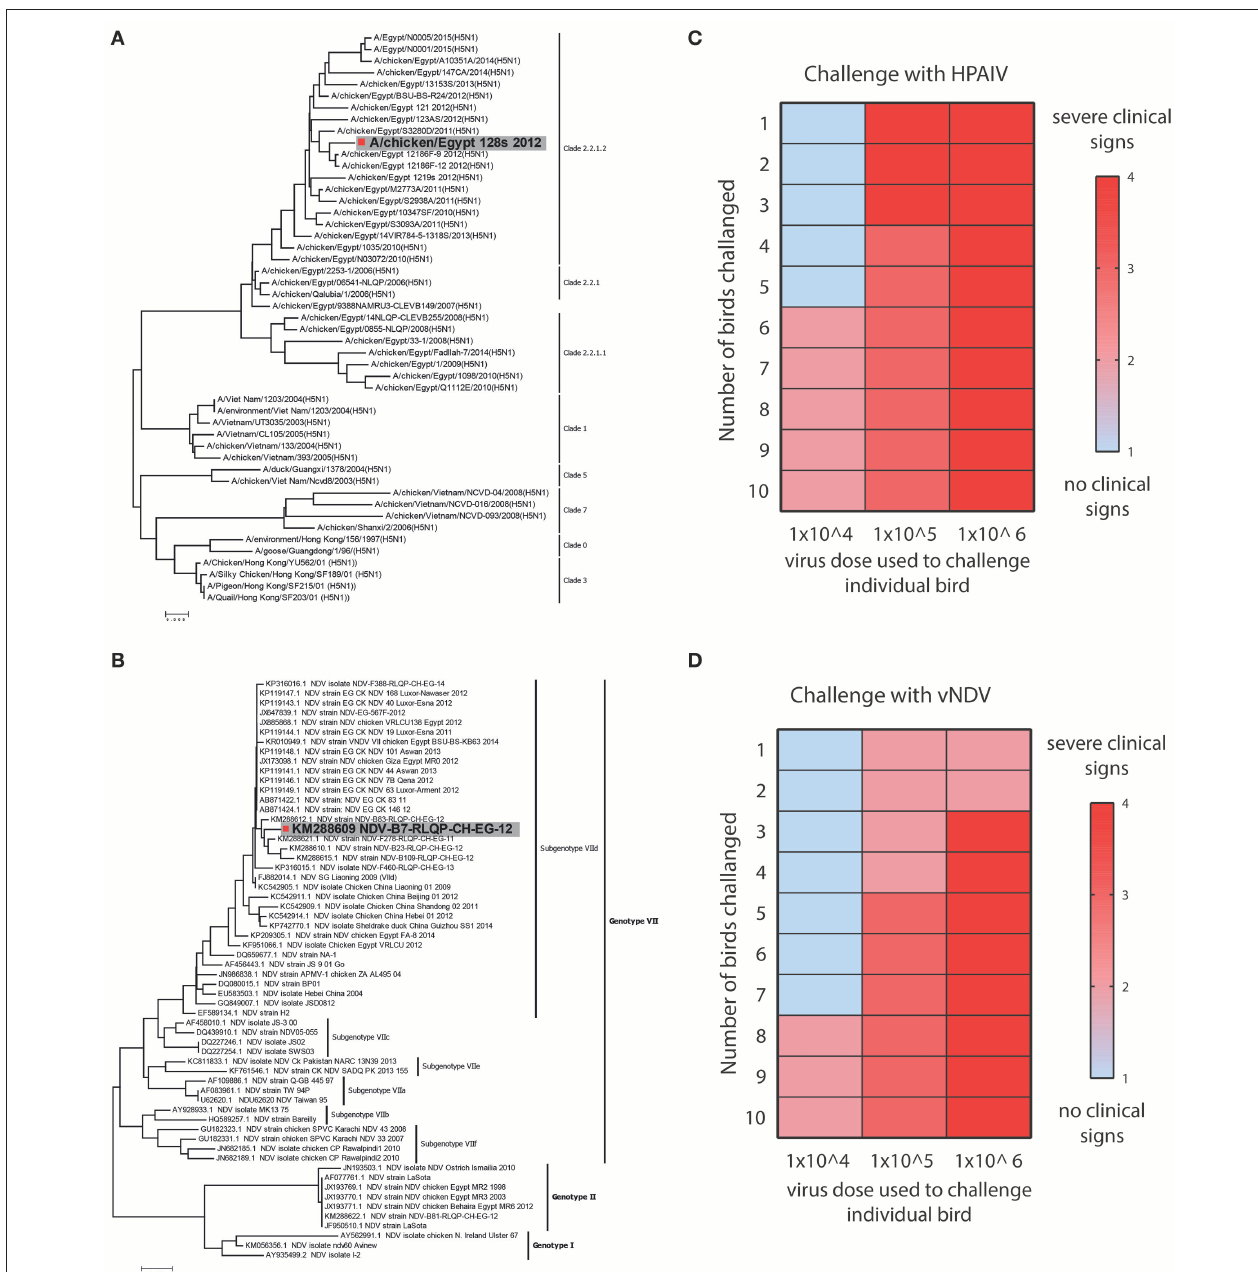
FIGURE 2 | Strain selection and clinical and lethal doses assessment for HPAIV and vNDV. (A) Bioinformatics analysis of representative strains of H5N1 and (B) velogenic strains of NDV. Strains used in this study are colored gray. (C) Twelve days old SPF-chickens were challenged with the EID 50 of 10 4 , 10 5 , and 10 6 HPAIV or (D) vNDV and the disease was monitored until 11 days post-infection. Color gradient represent the severity of clinical